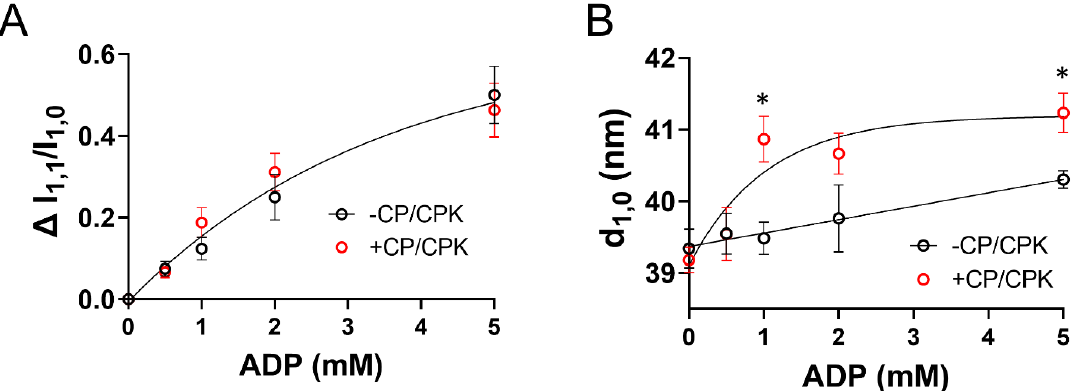
Figure 2. Equatorial reflection changes with increasing [ADP] under relaxing conditions (pCa 8.0). ( A ) Changes in the equatorial intensity ratio (ΔI 1,1 /I 1,0 ) and ( B ) lattice spacing (d 1,0 ) were plotted against [ADP], in the presence and absence of creatine phosphate (CP) and creatine phosphokinase (CPK). Two-way linear mixed models were utilized to characterize the main effects of ADP and CP/CPK and their interaction. Panel A depicts ΔI 1,1 /I 1,0 relative to 0 mM [ADP] for each condition with a significant main effect for ADP ( p < 0.001). In Panel B there were significant main effects of ADP ( p < 0.001), CP/CPK ( p = 0.004), and an ADP*CP/CPK interaction ( p = 0.02), with * indicating a Fisher’s LSD post hoc difference between − CP/CPK and +CP/CPK at a single [ADP] at p < 0.05. 9 fibers were used for each different CP/CPK group.